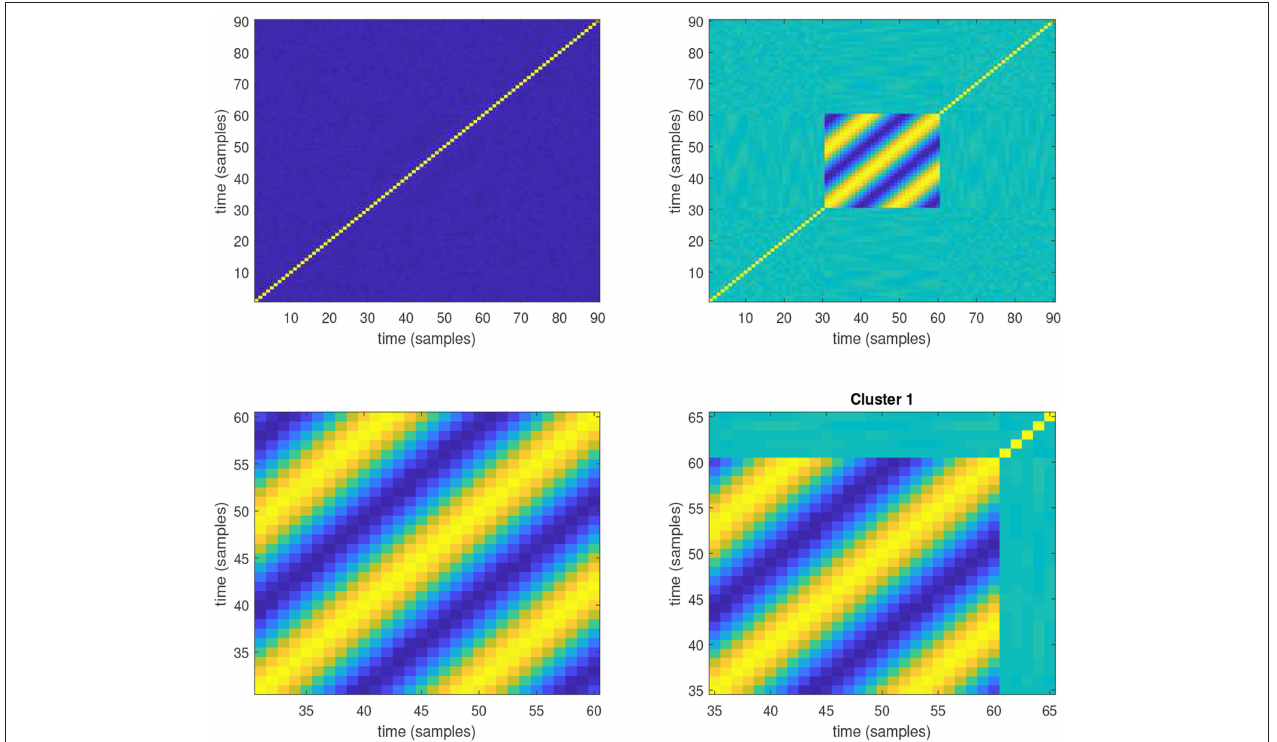
B of size n N ). = × 31, ... 60 ), i.e., frame 31 through 60. = { }